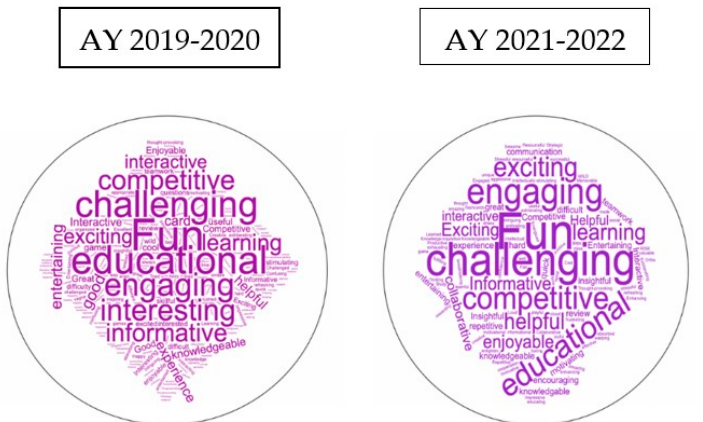
Figure 3. Sample word clouds. Word clouds demonstrate words used by students based on fre- quency describing the gameplaying experience (without prompts). AY 2019–2020 Word Cloud: 239 D2 students responded (RR = 66%). Most reported words were: 64% “fun”, 17% “educational”, 15% “engaging”, and 13% “challenging”. AY 2021–2022 Word Cloud: 115 D2 students responded (RR = 47%). Most reported words were: 54% “fun”, 25% “challenging”, 13% “engaging”, and 10% “edu- cational”. “Fun” was the most commonly occurring word in all years surveyed.